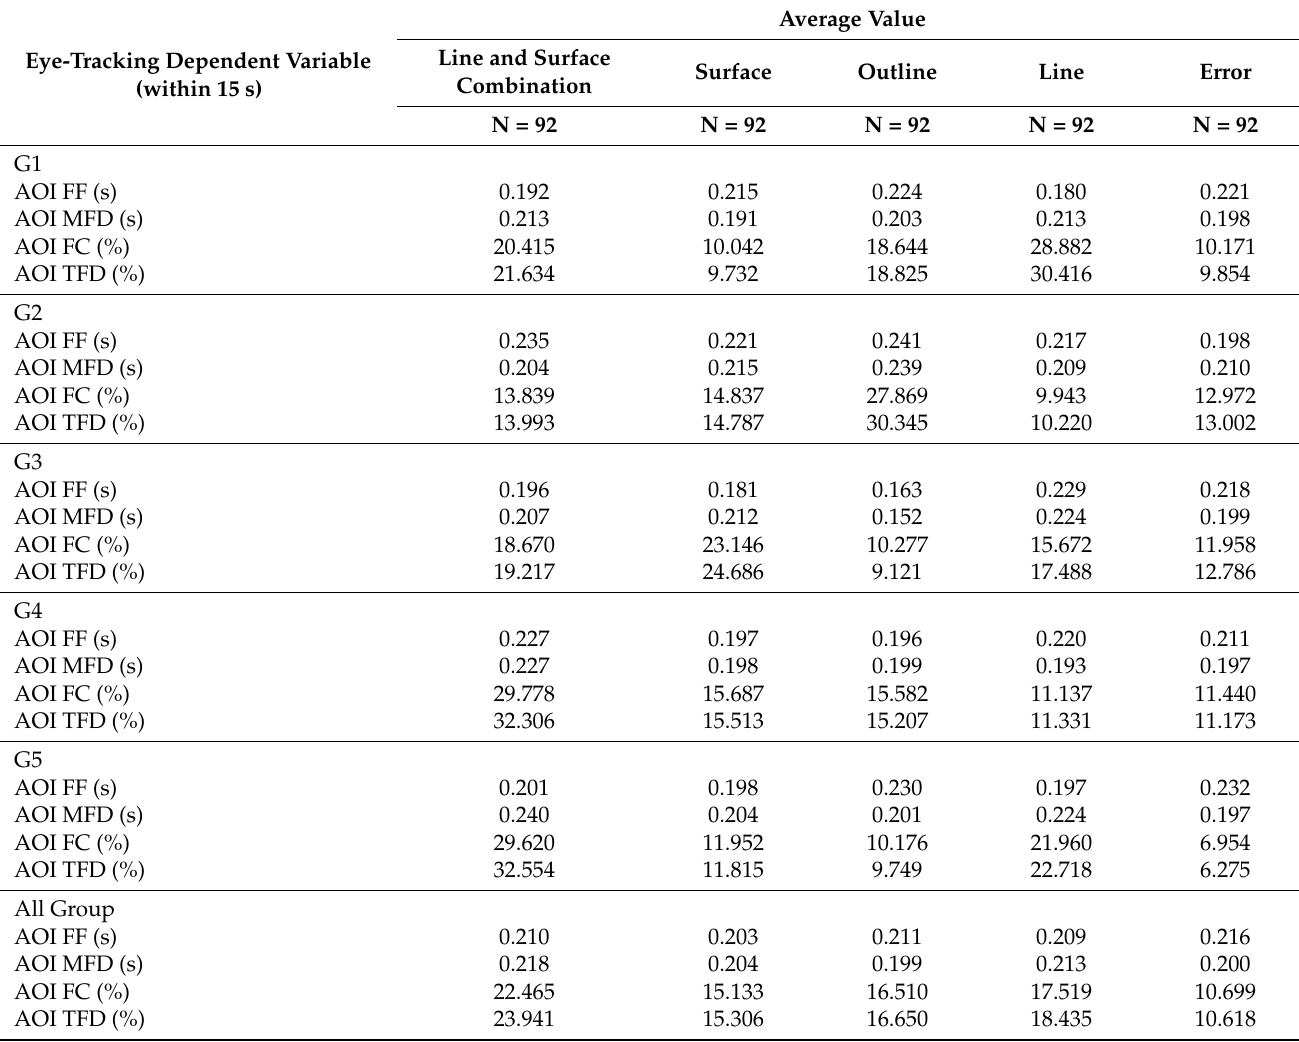
Table 6. Comparison of Eye-Tracking Index Data for the Five Types of